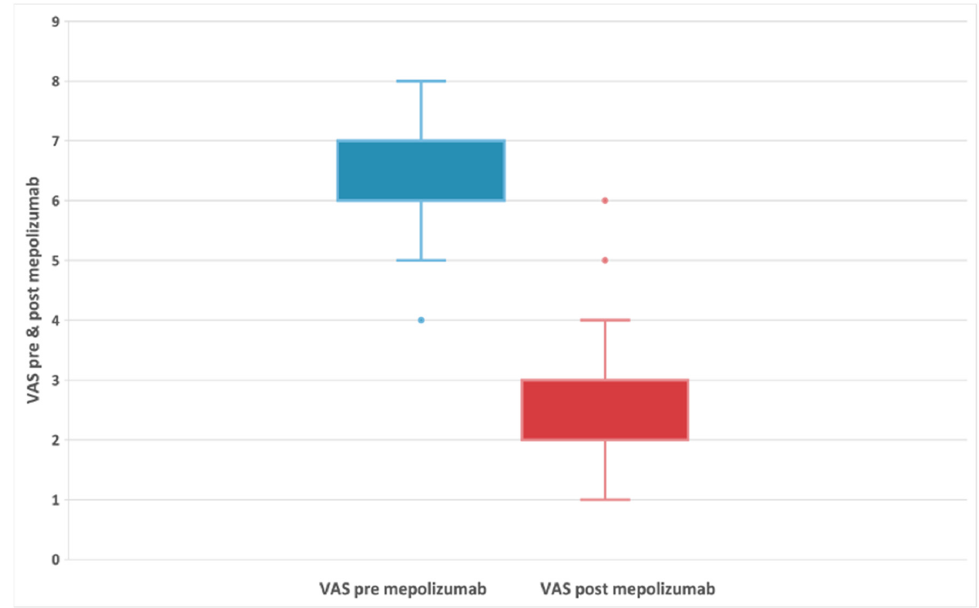
Figure 2. Evolution of VAS symptoms in patients with refractory chronic rhinosinusitis and nasal polyps, before and after 24-week treatment with 100 mg of mepolizumab every 4 weeks. There was a statistically significant decrease in NPS before treatment (median: 4; IQR:4;6) and after treatment (median: 1; IQR:0;1) with a median difference of − 4 and a p < 0.001 (Figure 3a and Table 2). The reduction in NPS was greater in patients with AERD (Figure 3b). In AERD patients, NPS score decreased by 4.5 points (95% CI: − 5; − 3.5) p < 0.001. In contrast, patients without AERD had a smaller median decrease (median differ- ence: − 4; 95% CI: − 4.5; − 3) p < 0.001.